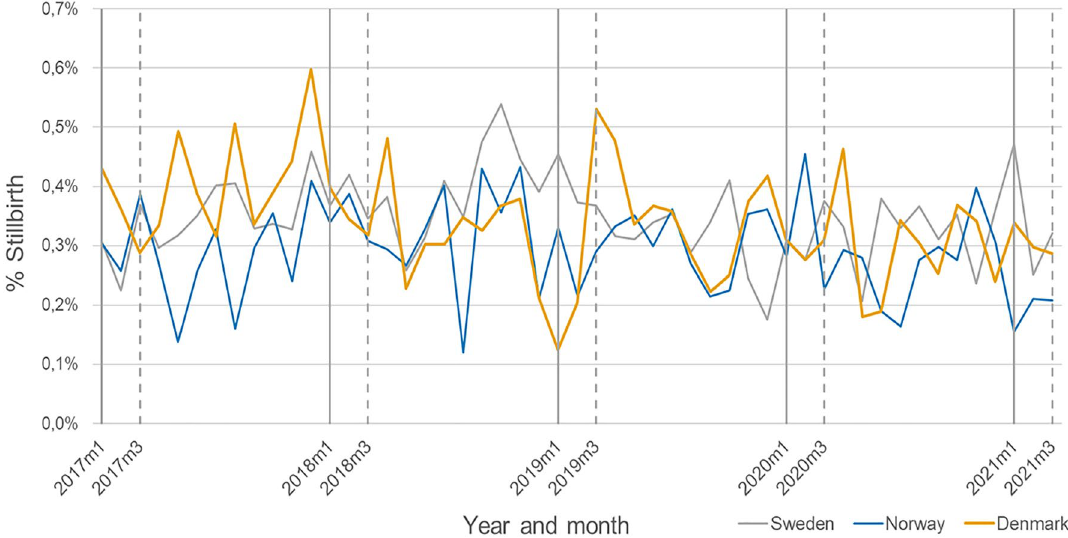
Figure 3. Proportion of deliveries ending in a stillbirth in Sweden, Denmark and Norway between January 2017 and March 2021. Calendar week 11 corresponds to the week of March 12th